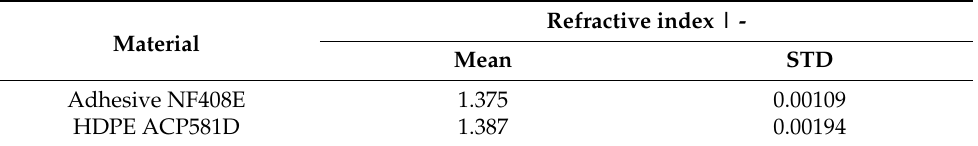
Table 8. Refractive indices of the adhesive and the HDPE melt at a wavelength of 1300 nm.